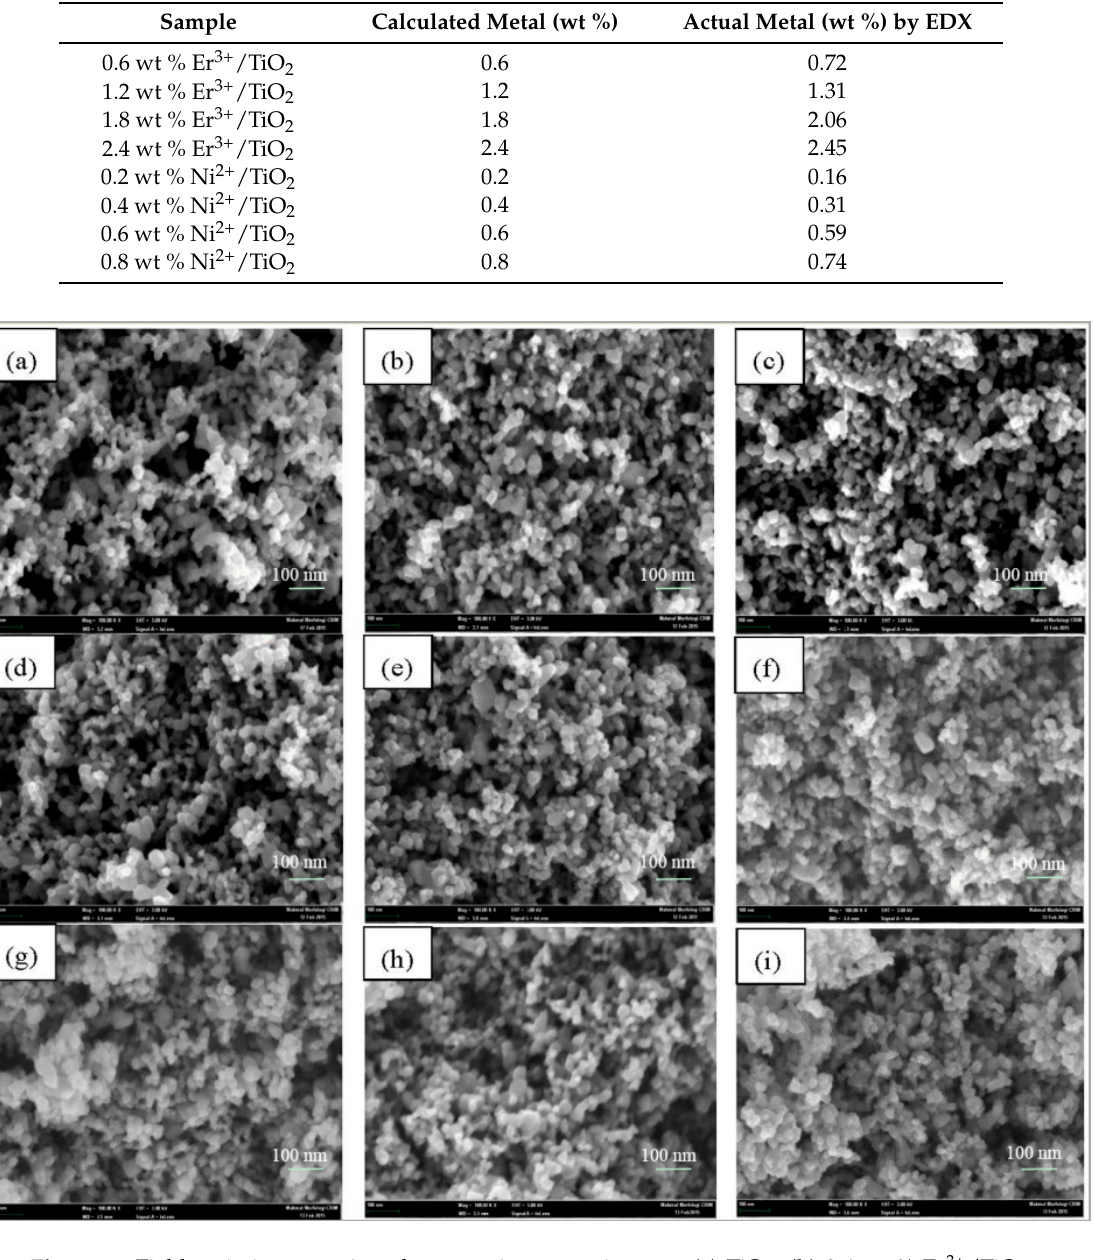
Figure 3. Field emission scanning electron microscopy images: ( a ) TiO 2 ; ( b ) 0.6 wt % Er 3+ /TiO 2 ; ( c ) 1.2 wt % Er 3+ /TiO 2 ; ( d ) 1.8 wt % Er 3+ /TiO 2 ; ( e ) 2.4 wt % Er 3+ /TiO 2 ; ( f ) 0.2 wt % Ni 2+ /TiO 2 ; ( g ) 0.4 wt % Ni 2+ /TiO 2 ; ( h ) 0.6 wt % Ni 2+ /TiO 2 ; and ( i ) 0.8 wt % Ni 2+ /TiO 2 . Table 4. Calculated and actual wt % of Er and Ni on TiO 2 surface using energy dispersive X ‐ ray (EDX).